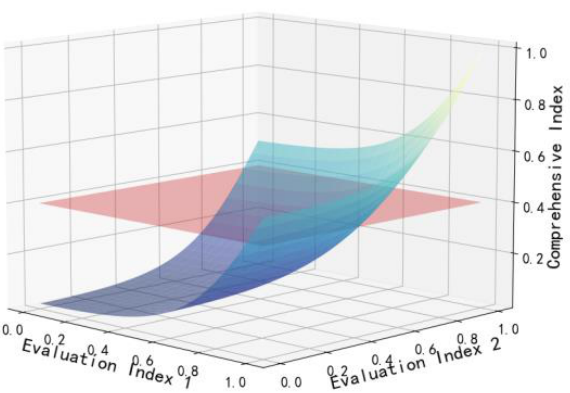
Figure 9. Schematic diagram of comprehensive evaluation index surface and threshold plane.